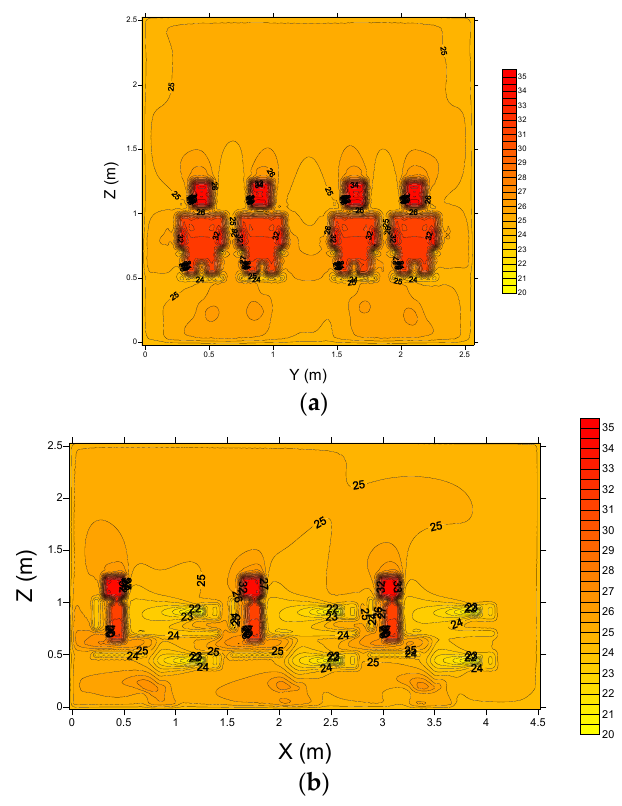
Figure 10. Air temperature field in the virtual classroom with 12 occupants in the plans ( a ) X = 1.791 m and ( b ) Y = 0.4423 m, with an inlet air temperature of 20 °C.